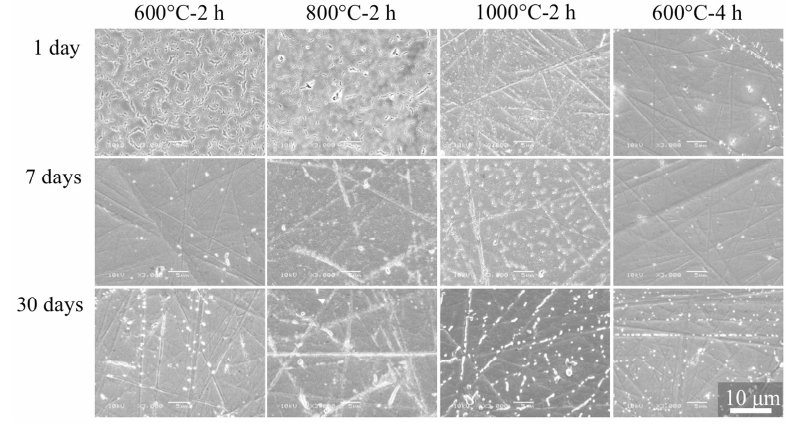
Figure 6. SEM images of the Y ‐ TZP disks of four heating conditions after 1, 7, and 30 days of PBS immersion.